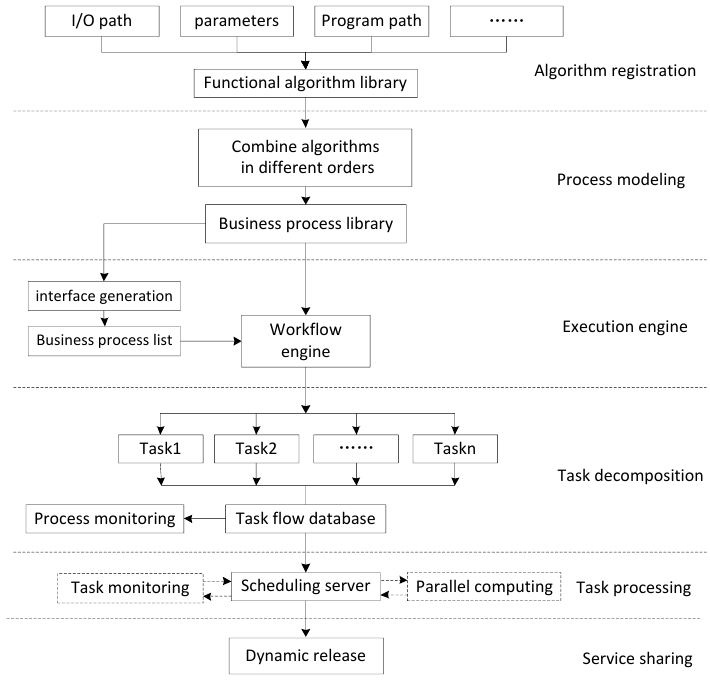
Figure 1. The operation mechanism for the Cloud geographic information system (GIS) business process on-demand extension